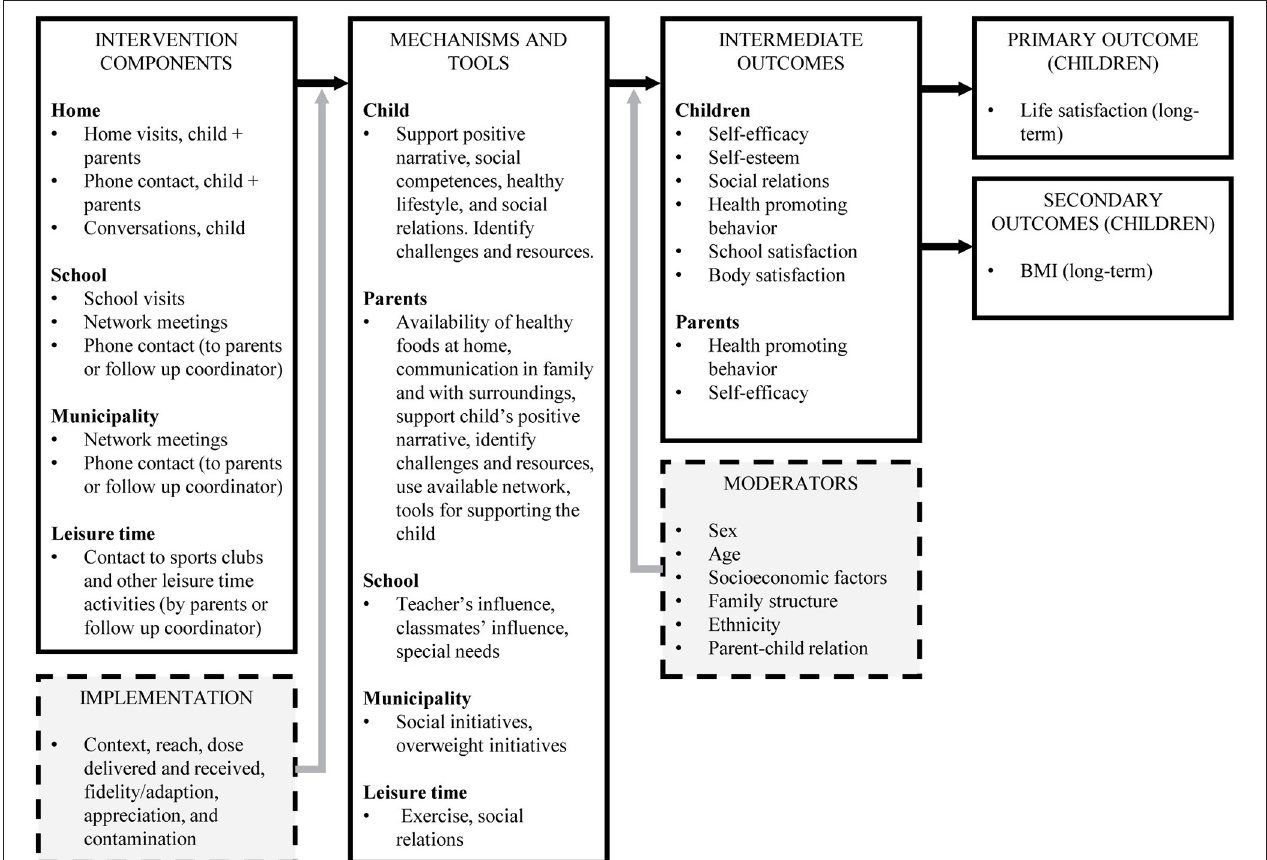
FIGURE 2 | Program theory for extended maintenance